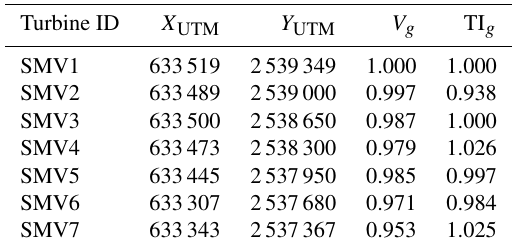
Table 4. P4: non-homogeneous factors for the multiple-wake case.